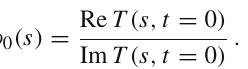
Table 1 The values of the fitted ReBB model parameters to pp and p ¯ p data from SPS to LHC energies. The errors and the values are rounded up to three valuable decimal digits. For 7 TeV, the parameter error values shown in parenthesis do not include the contribution from the parameter correlations, i.e., are less than the MINOS errors